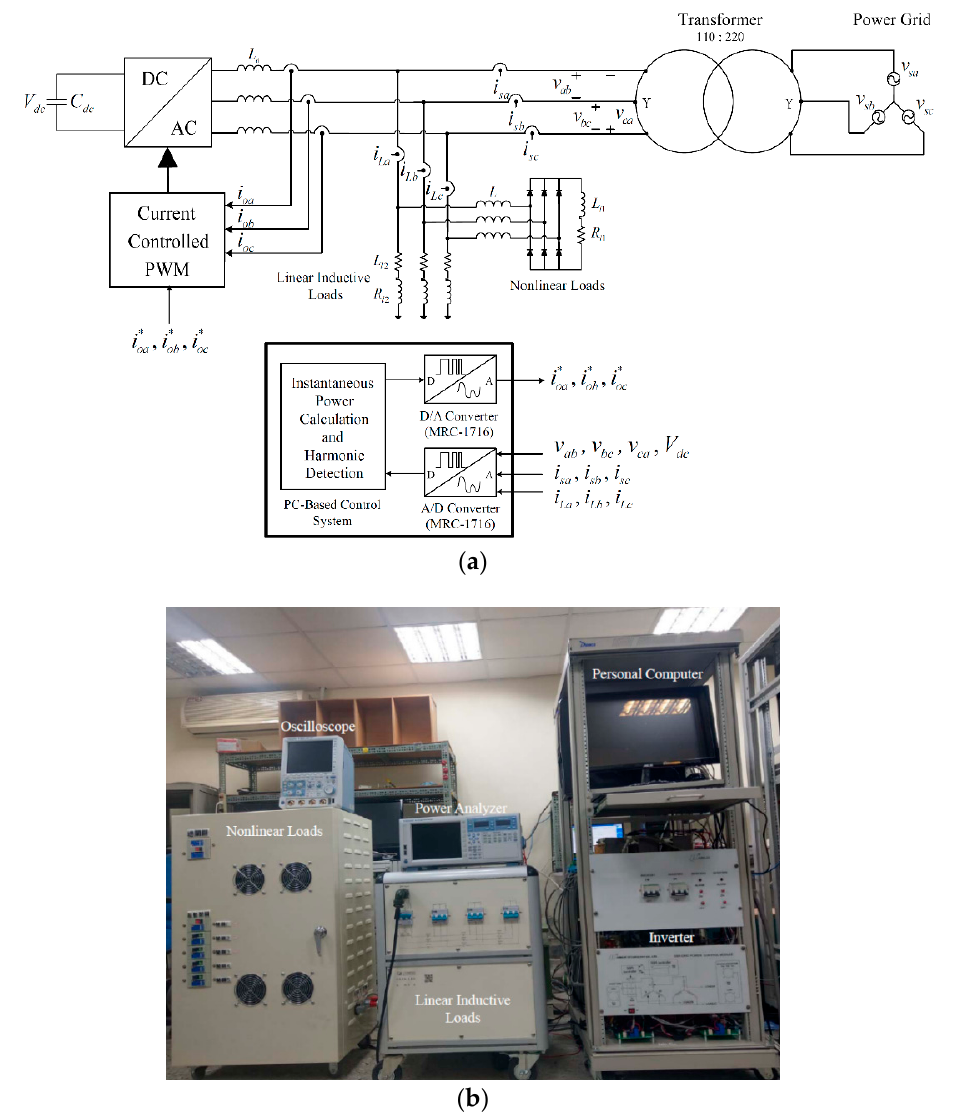
Figure 4. PC-based DSTATCOM: ( a ) Block diagram of DSTATCOM; ( b ) Photo of control platform, loads and inverter. Table 1. Current THDs without using DSTATCOM and using DSTATCOM with different controllers at nonlinear loads